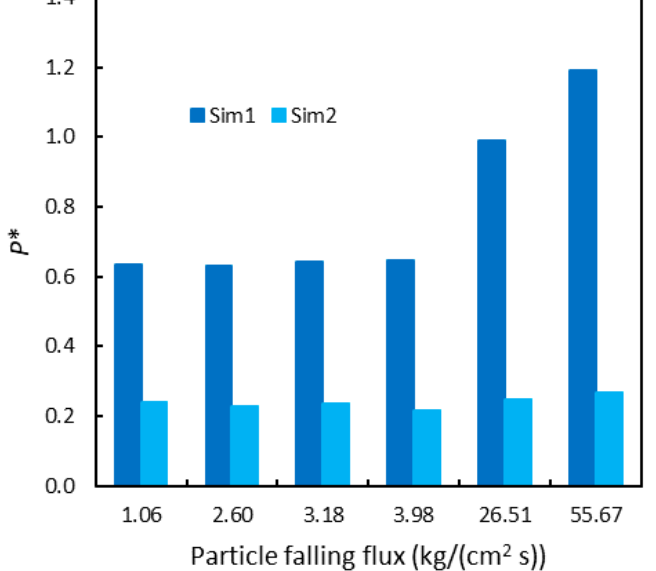
Figure 11. Pressure at the bottom upon varying the falling particle flux.